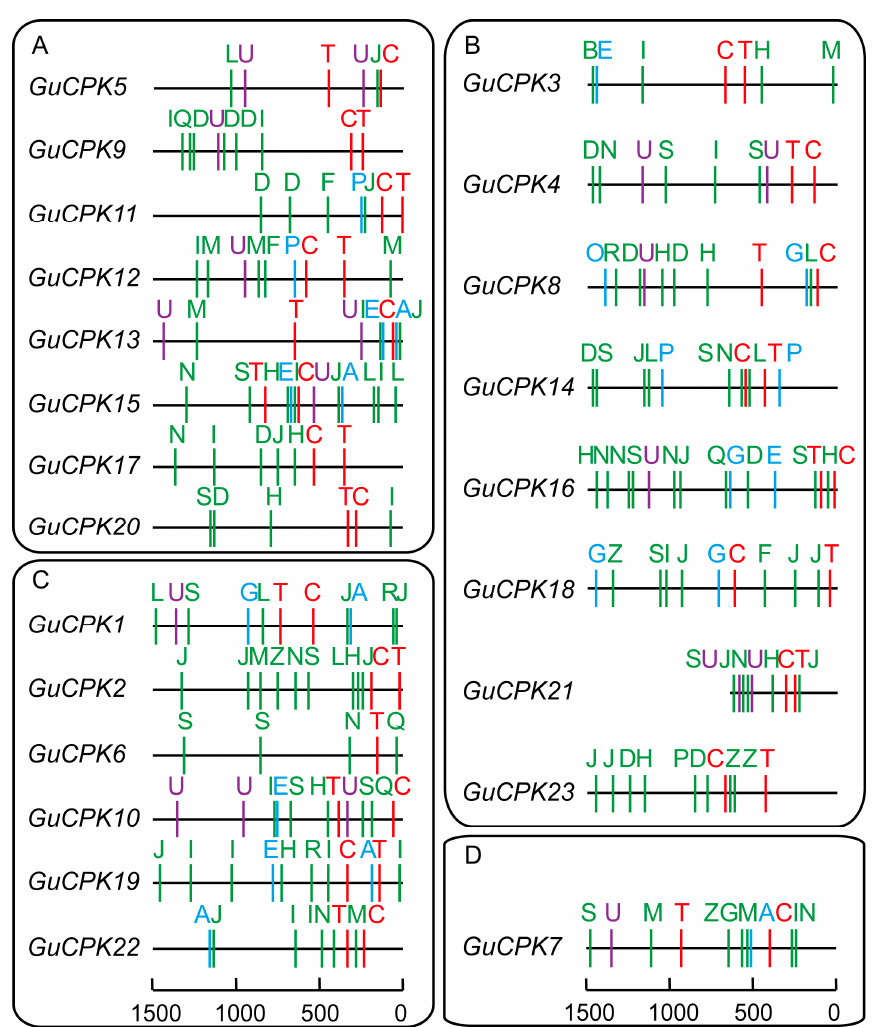
Figure 6. Distribution of cis -elements in GuCPK gene promoter regions. The cis -elements of the 1.5-kb upstream promoter regions of GuCPKs were predicted using PlantCARE software. The GuCPKs were divided into four groups according to the phylogenetic subfamilies (groups I–IV). Colored capital letters represent different cis -elements at corresponding positions. Red, green, purple, and blue letters indicate core elements, phytohormone response, stress response, and the high transcription of cis -elements, respectively. Detailed information for each cis -element is provided in Supplementary Table S4.